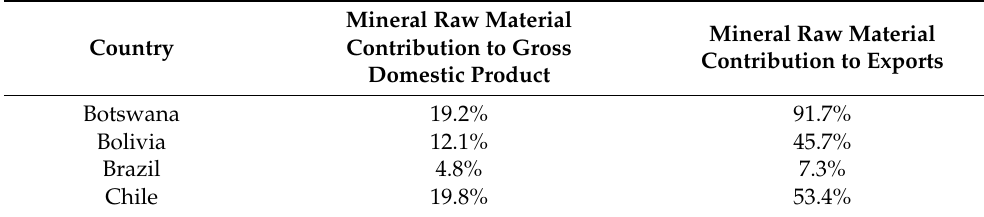
Table 3. Contribution of raw materials to the economies of selected developing nations with an ASM share of less than 5% for 2019 (source [79,80]).